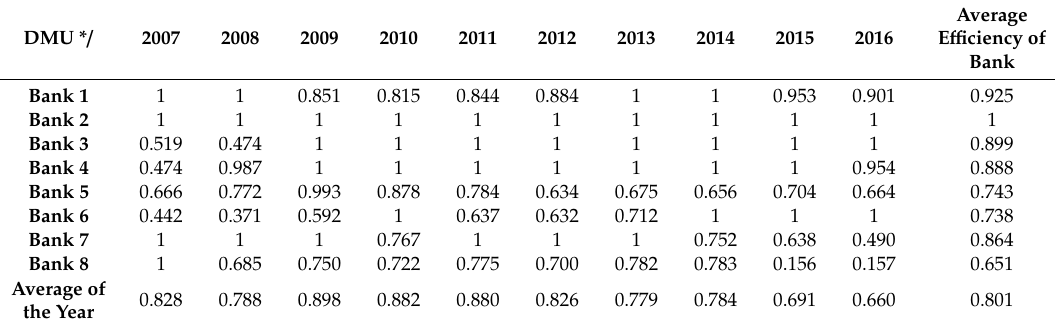
Results of DEA model 1 (Output oriented, VRS (Variable Returns to Scale) model; input Mortgage Credits, output Interest Margin). DMU * /